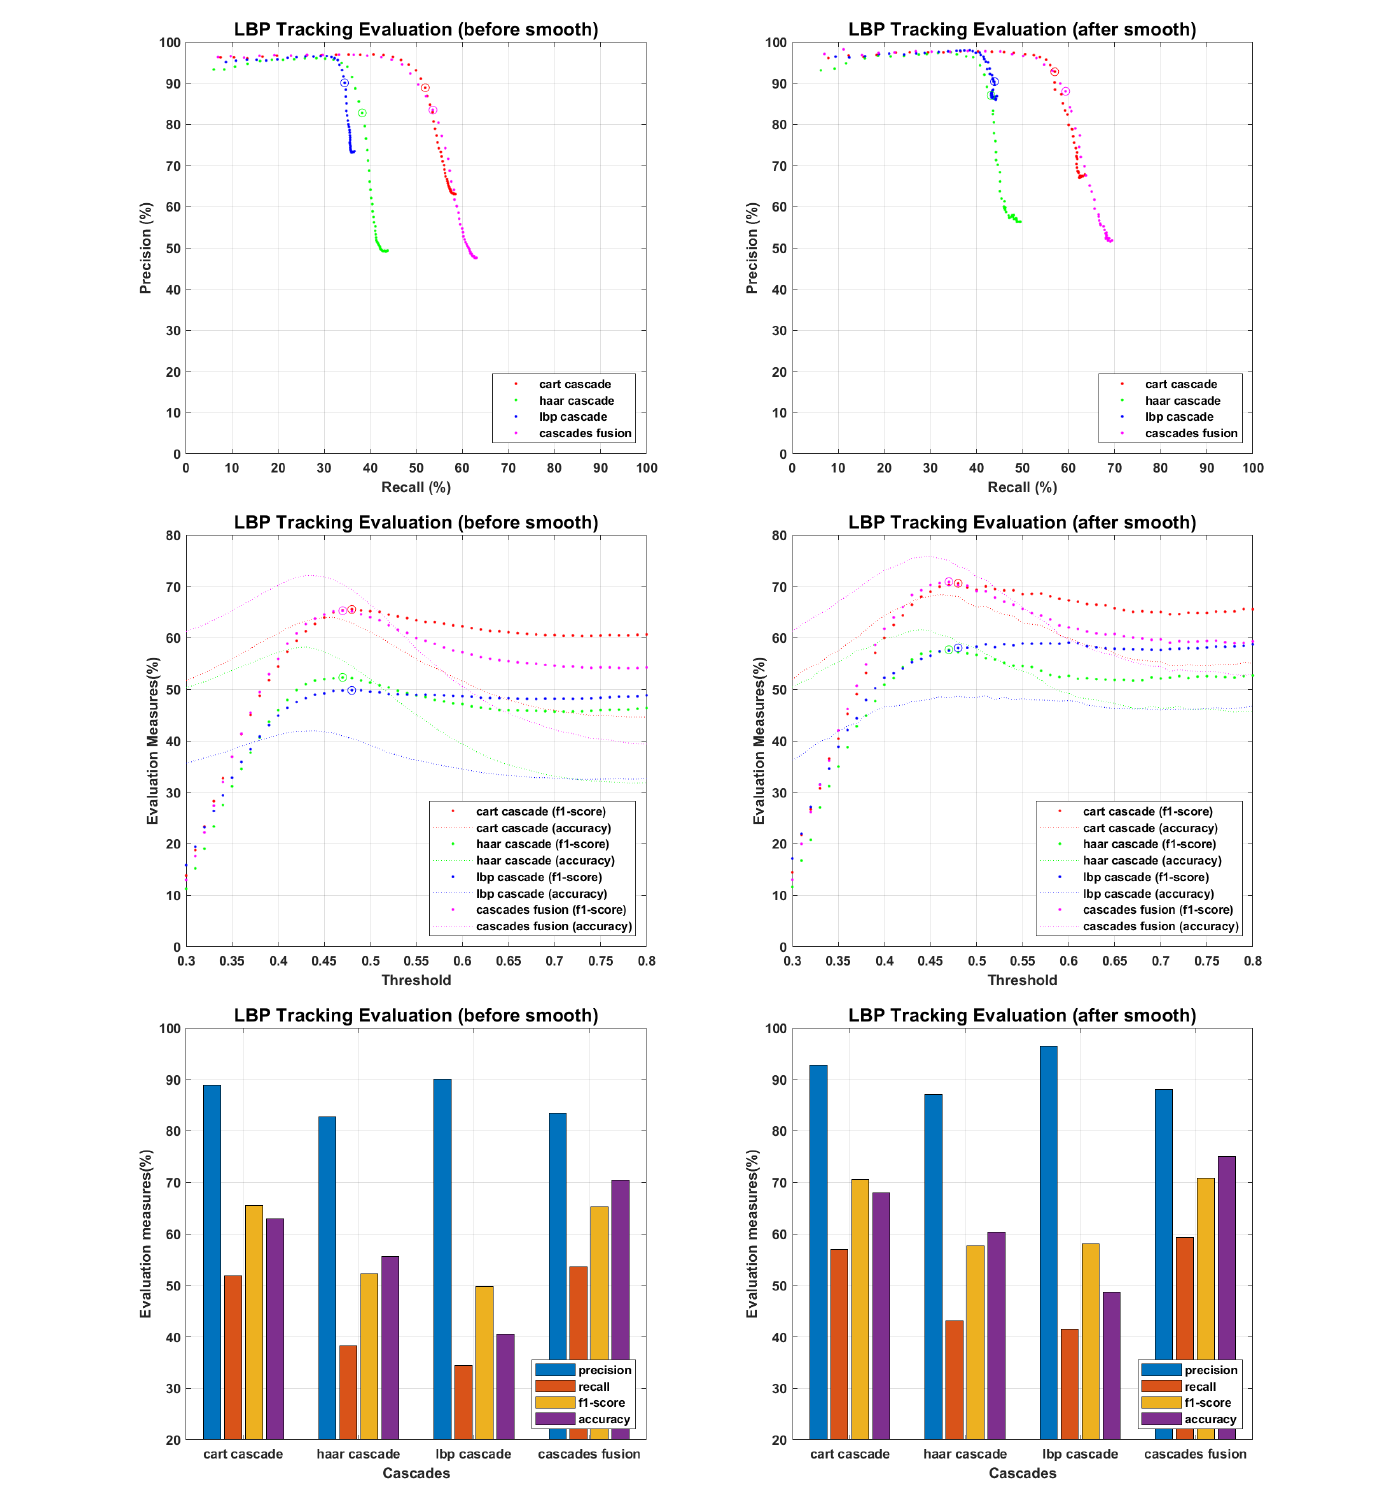
Figure 17. Tracking Evaluation for